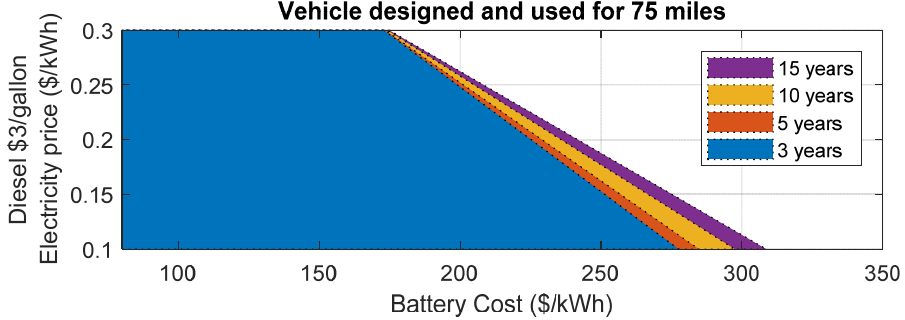
Figure 10. Impact of service duration on TCO parity of a class4 electric truck.